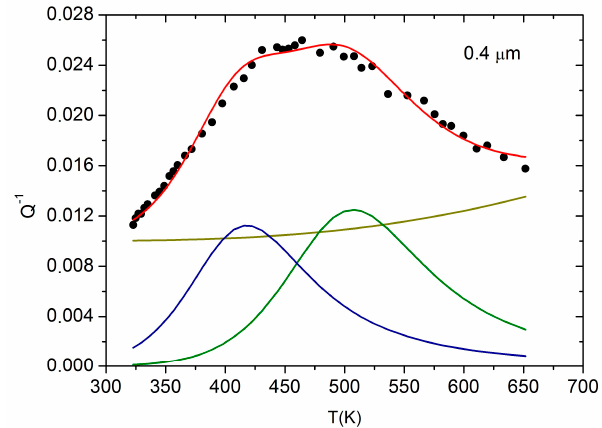
Figure 4. Q − 1 vs. temperature curve of a 0.4 µm thick film deposited on a silicon substrate after the subtraction of the substrate contribution. Experimental data are fitted as the sum (red curve) of an increasing exponential background (dark green curve), and two peaks with activation energies of 0.51 eV and 0.56 eV (green and blue curves) [11].